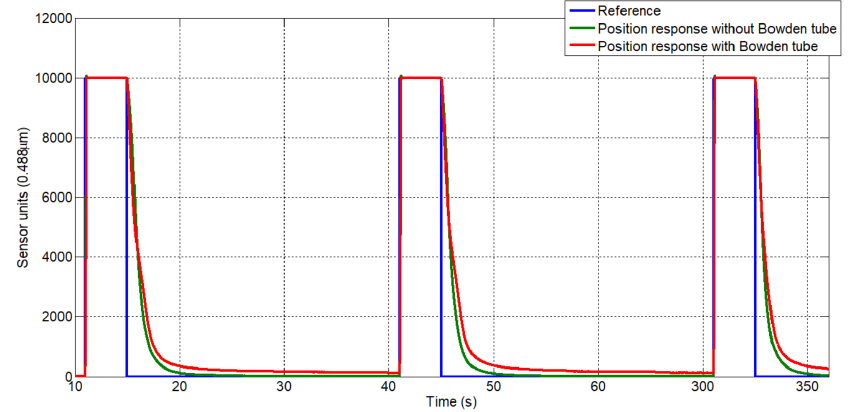
Figure 7. SMA of 0.51 mm diameter position response with Bowden cable vs. without Bowden cable.